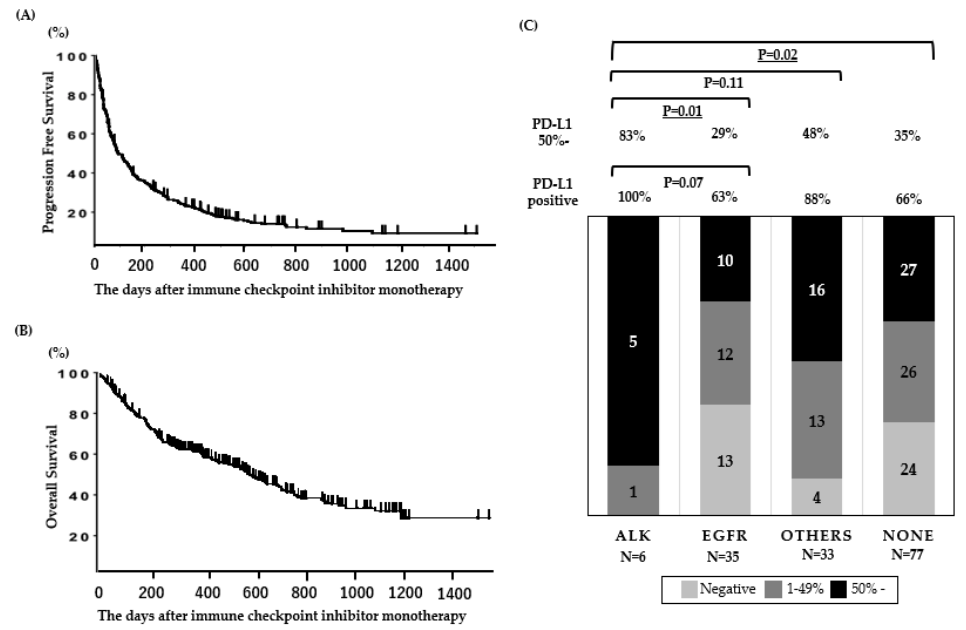
Table 2. Univariate and multivariate analyses for progression-free survival of ICI-treated patients.